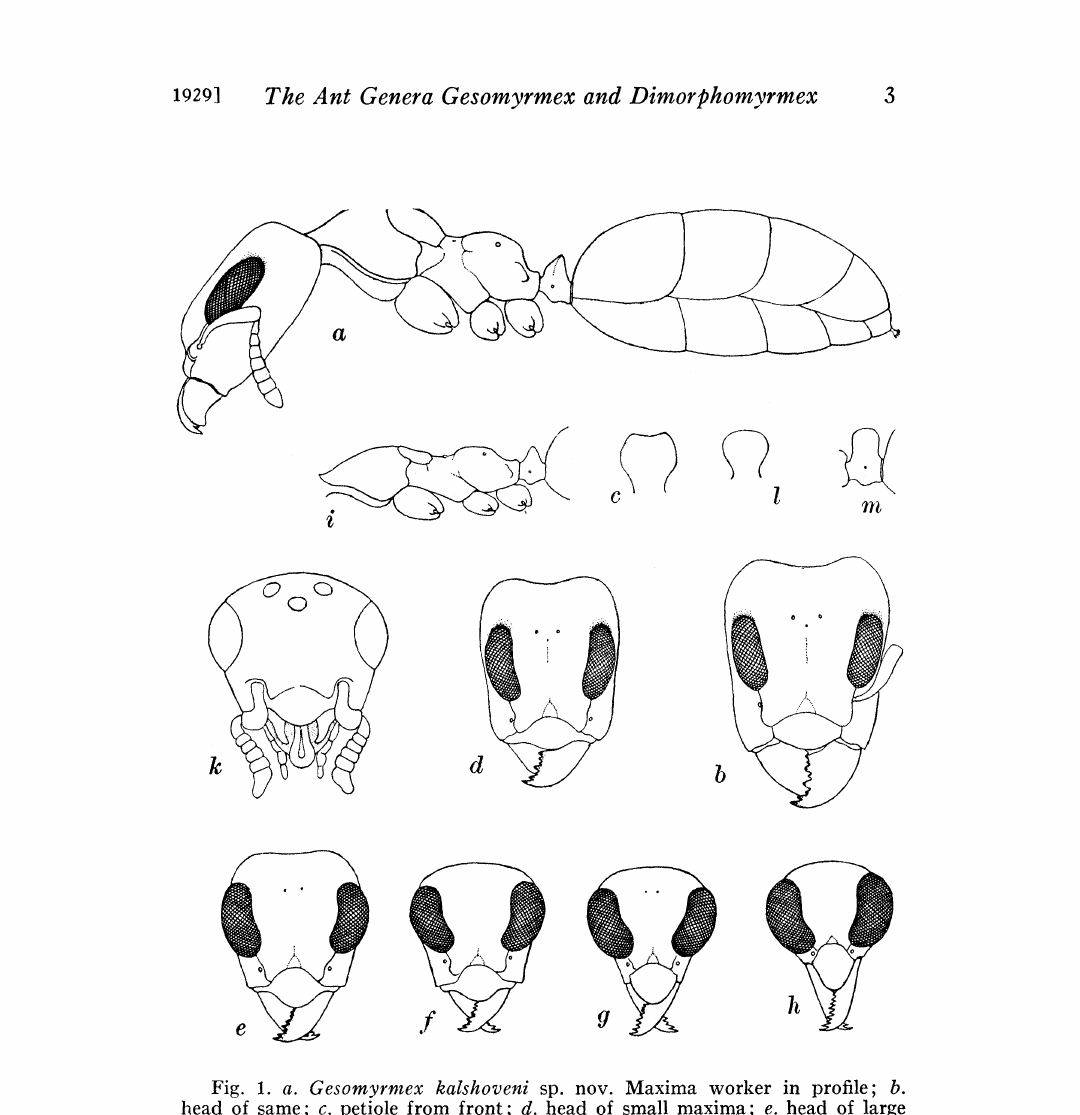
Fig. 1. a. Gesomyrmex kalshoveni sp. nov. Maxima worker in profile; b. head of same; c. petiole from front; d. head of small maxima; e. head of large media; J. of small media; g. of large minima; h. of small minima; i. thorax and petiole of same; k. head of male semipupa; l. petiole of G. howardi Wheeler from front; m. same in